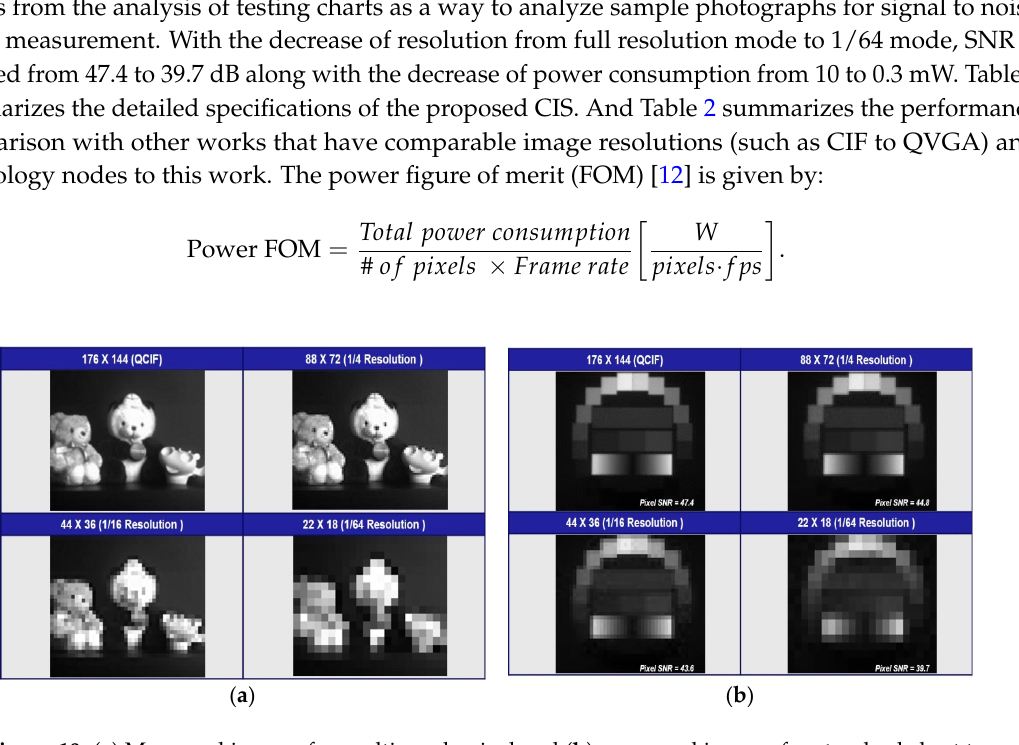
Figure 9. ( a ) The chip layout of the proposed CIS and ( b ) microphotograph of the fabricated CIS.